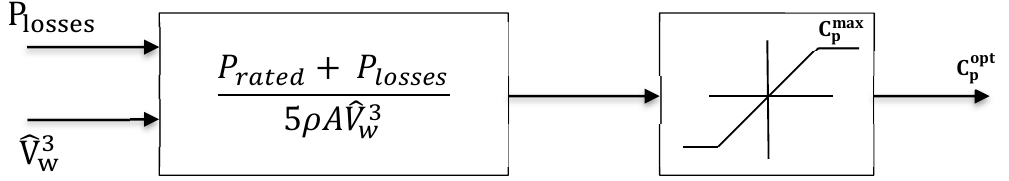
Figure 5. Calculation of optimal power coefficient.